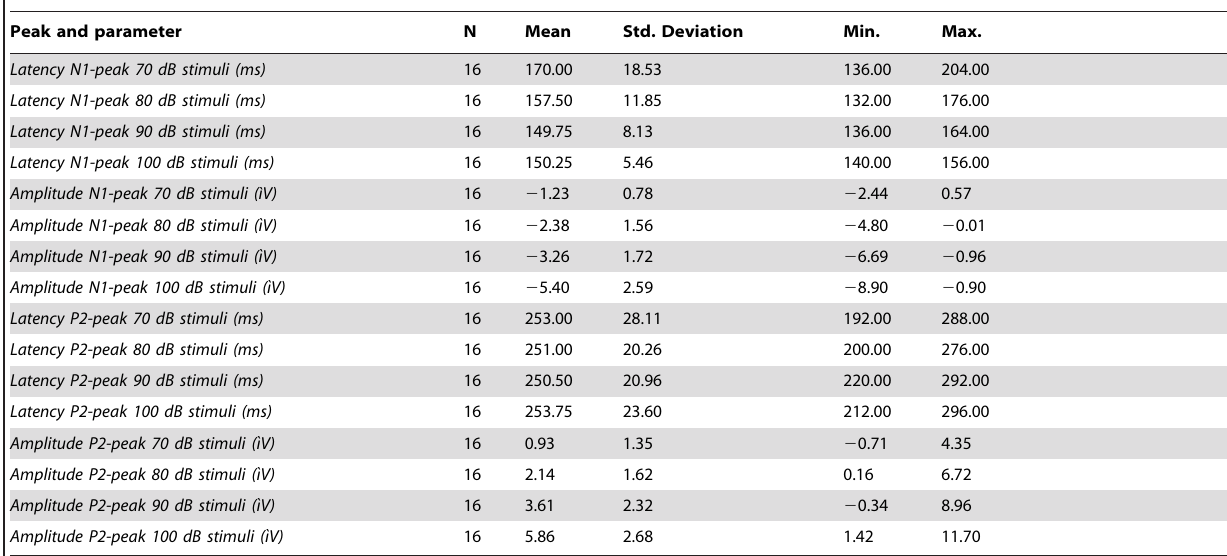
Table 1. Descriptive statistics of N1 and P2 ERPs.